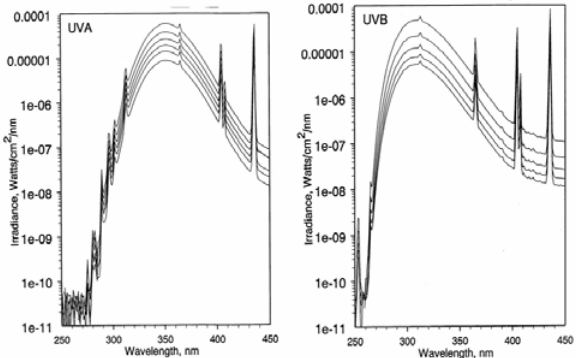
Figure 2: The light wavelength distribution of the (A) UVA and (B) UVB light sources The maximum emission of the unfiltered high output UVB fluorescent lamps was 313 nm, with a spectral distribution (right spectrum in Figure 2) as follows: UVC (250-280 nm), 1.01 x 10 -5 Watts/cm 2 ; UVB